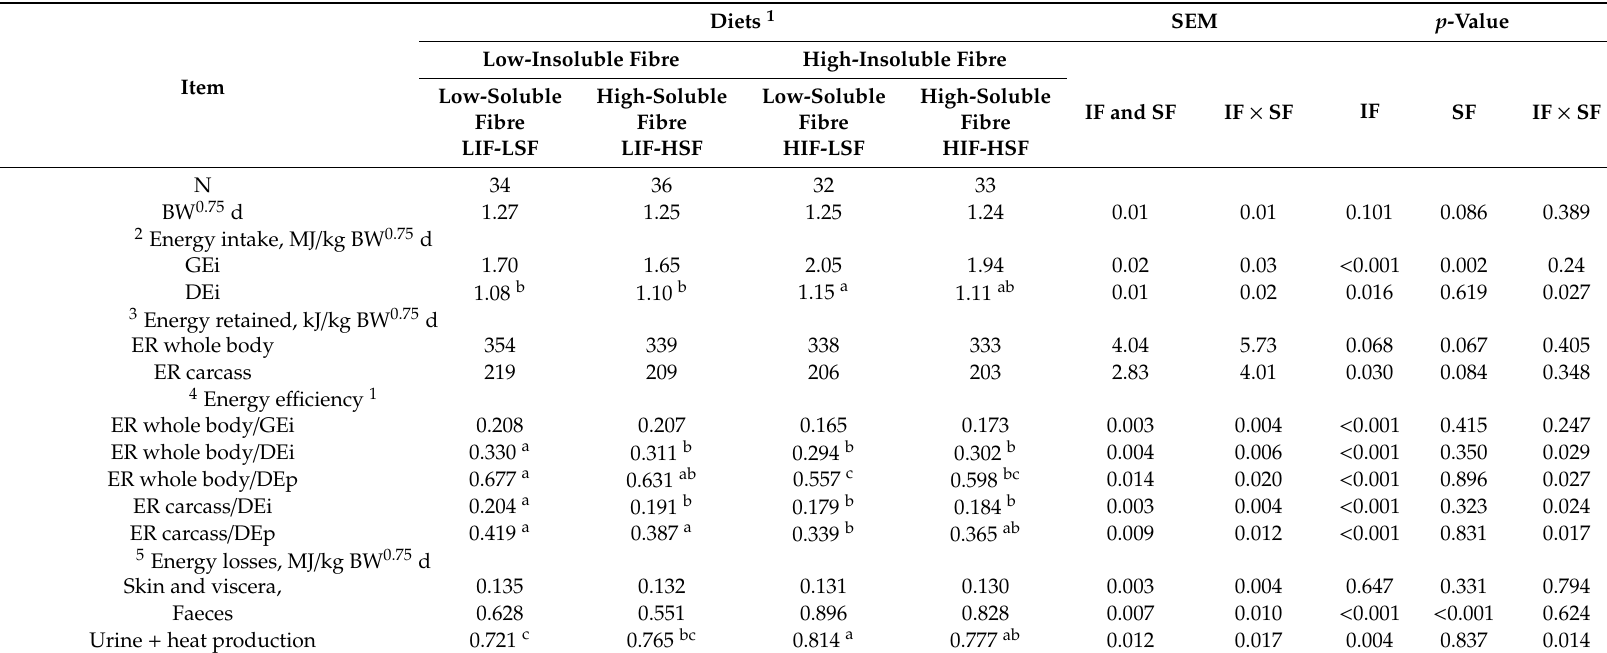
Table 5. E ff ect of dietary level of insoluble and soluble fibre on energy (E) balance from 28 to 62 days of